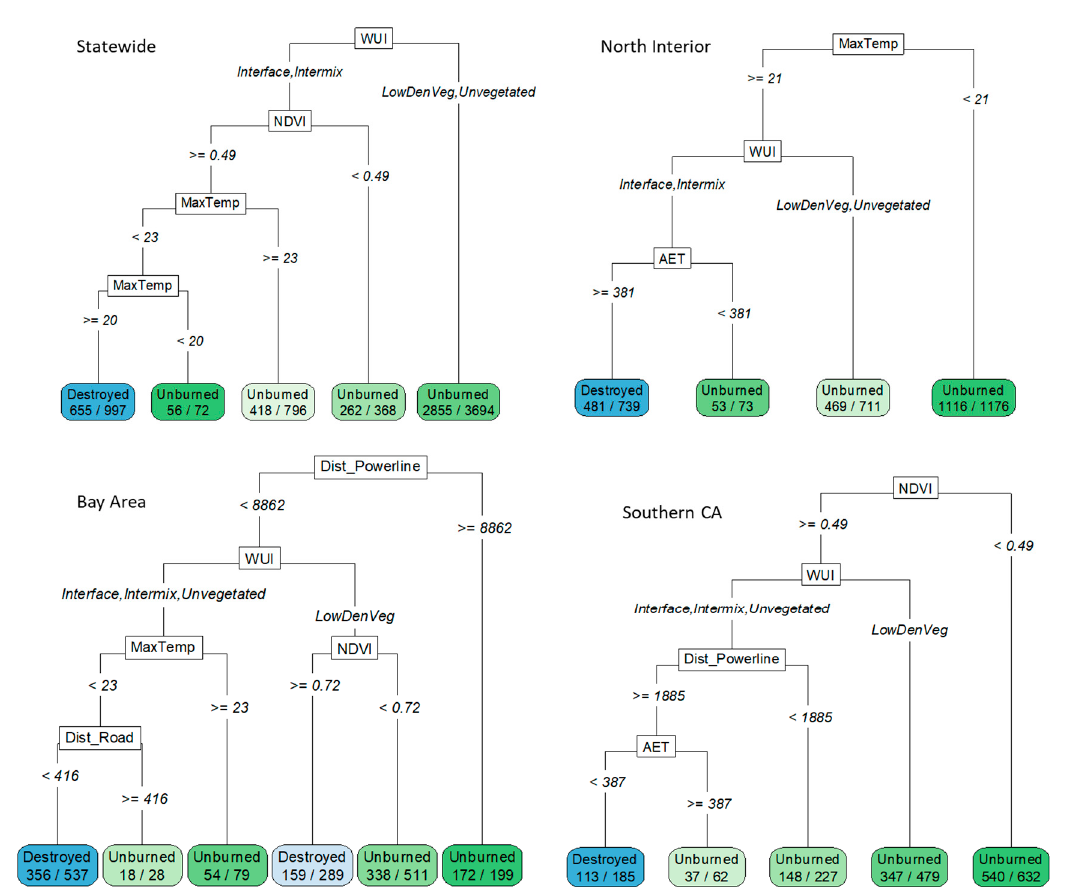
Figure 5. Classification trees illustrating variables explaining unburned versus destroyed structures statewide and for three California regions. The NDVI variable is for 30 m distance around structures (90 and 300 m not included). The intensity of the blue and green node colors is proportional to the percentage of observations. For variable explanations, refer to Table 1.